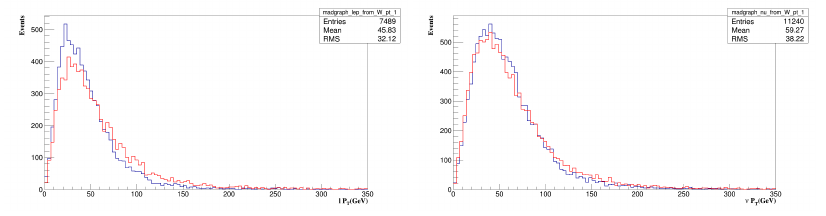
Figure 3. Transverse momenta of charged leptons (left) and neutrino (right) from the W decays. Blue histograms show the SM case, red histograms are for the ITC